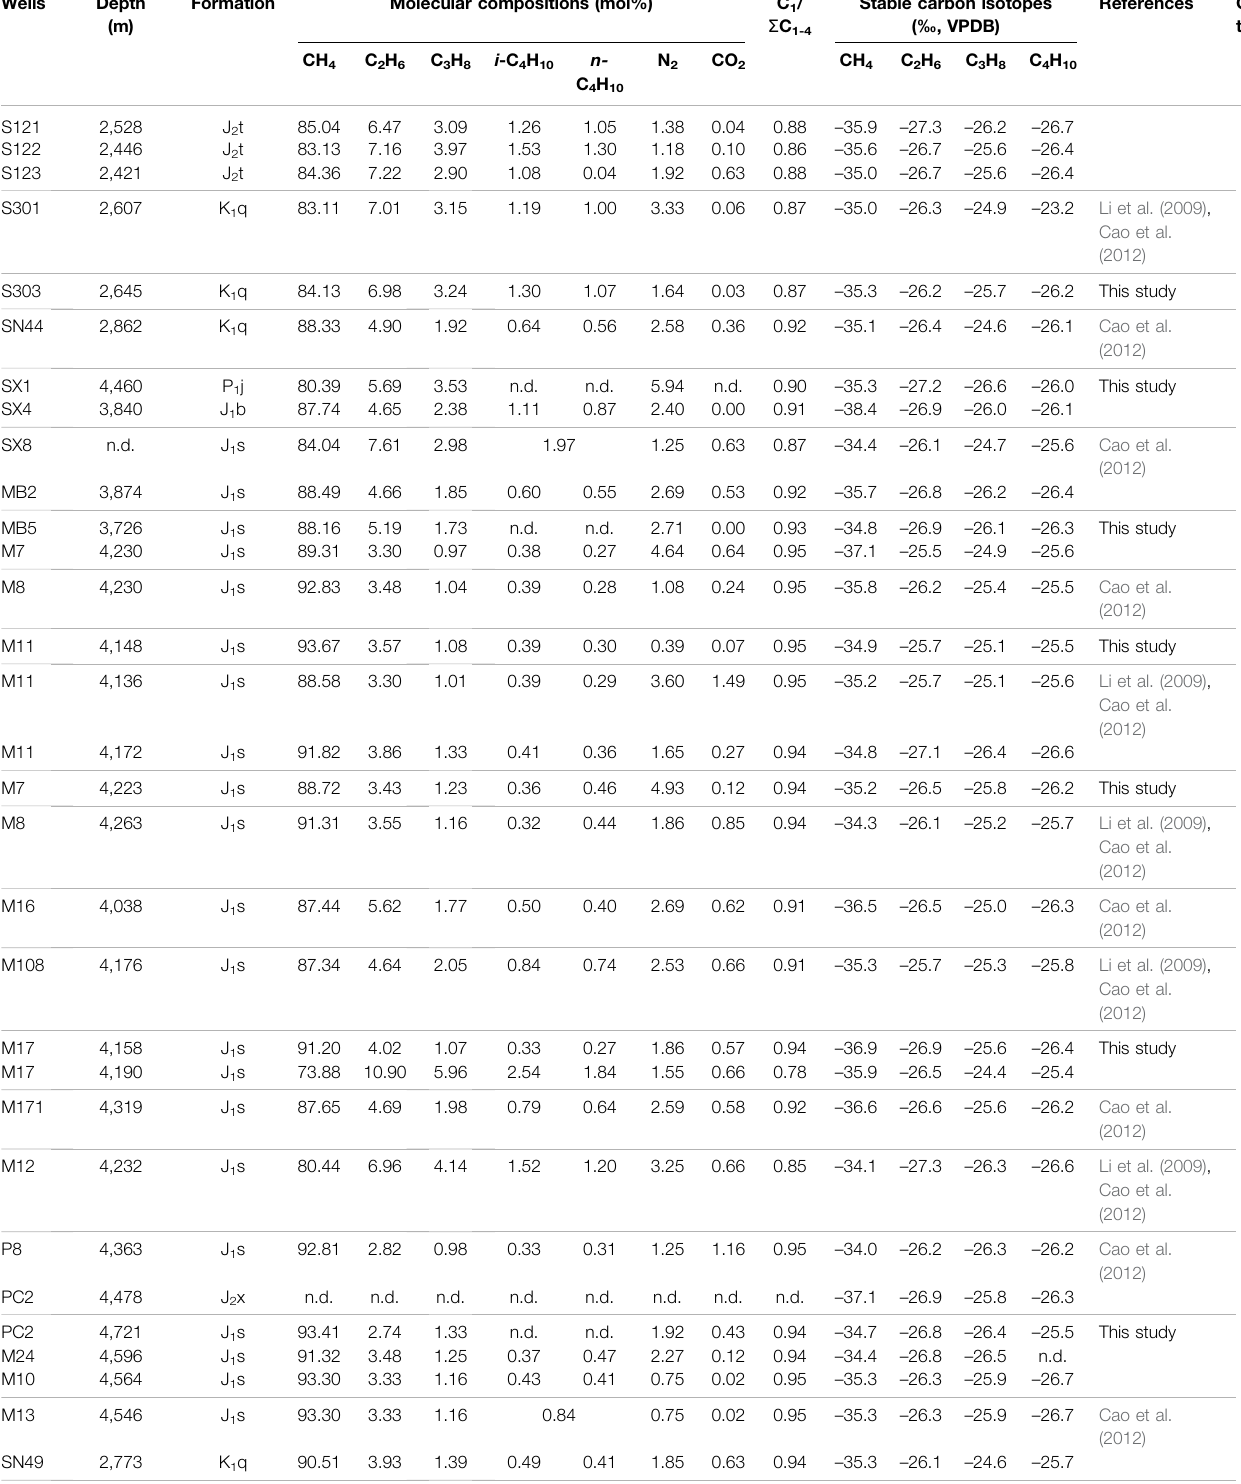
TABLE 1 | ( Continued ) Molecular and stable carbon isotopes of natural gases in the central Junggar Basin.